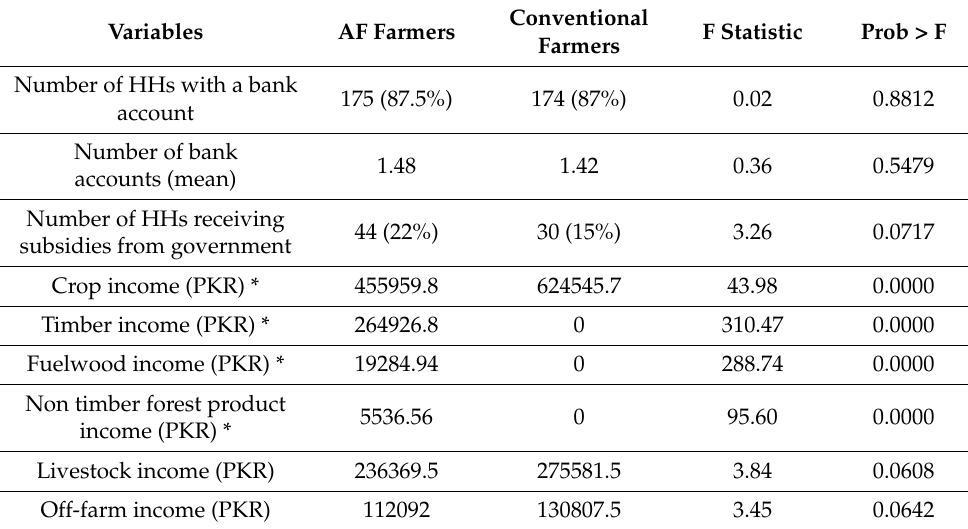
Table 2. Comparative analysis of the financial capital of AF and CF